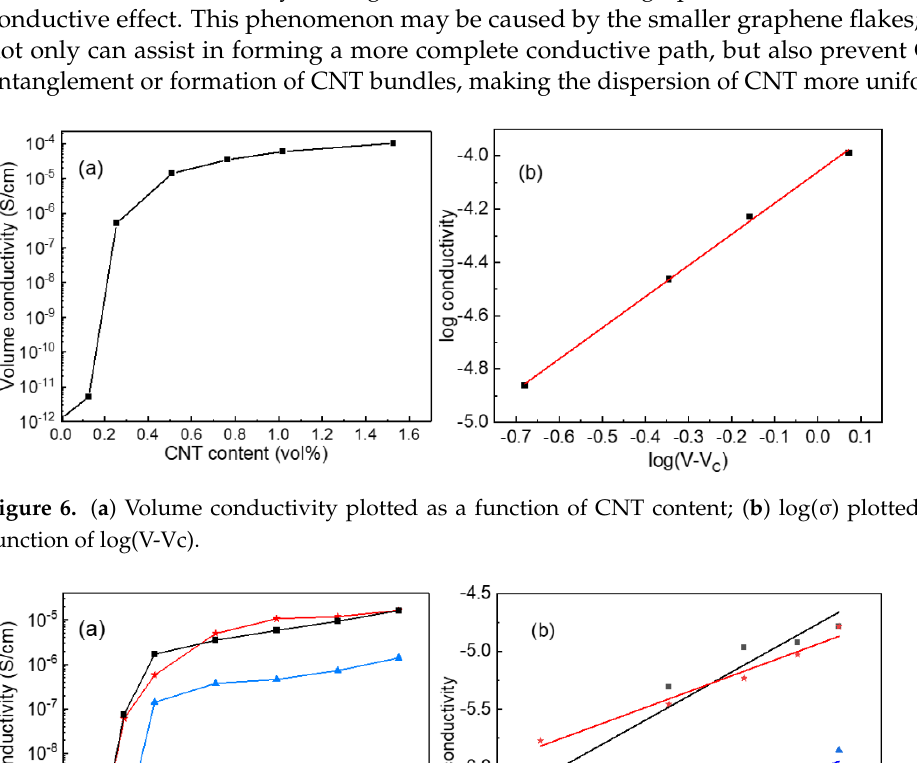
Figure 6. ( a ) Volume conductivity plotted as a function of CNT content; ( b ) log( σ ) plotted as a fun c- tion of log(V-Vc).